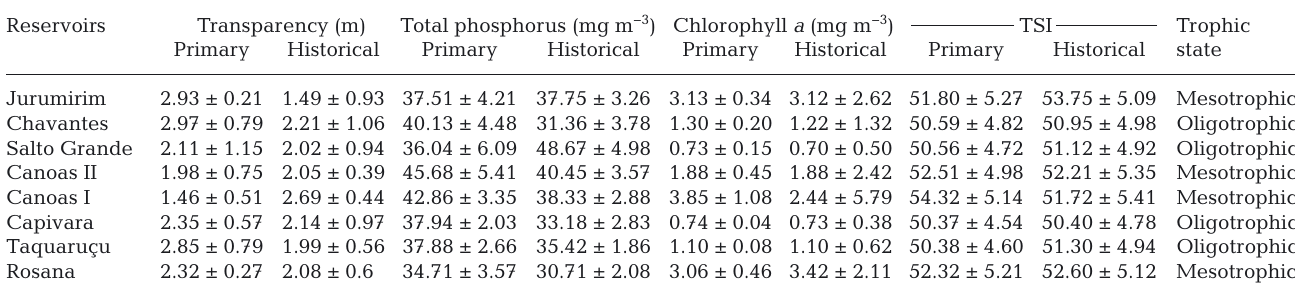
Table 10. Trophic state classification of the Paranapanema River artificial reservoirs based on the trophic state index (TSI; see Table 2) and calculated using water quality parameters from historical and primary data. Trophic state classification was determined using the mean of the calculated values based on historical and primary data and by comparing the results with the classification proposed by Cunha et al. (2013). Values are means ±